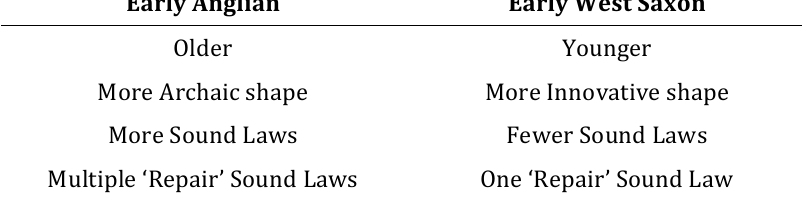
Table 2 : The chronological-typological inversion of sound laws in Old English